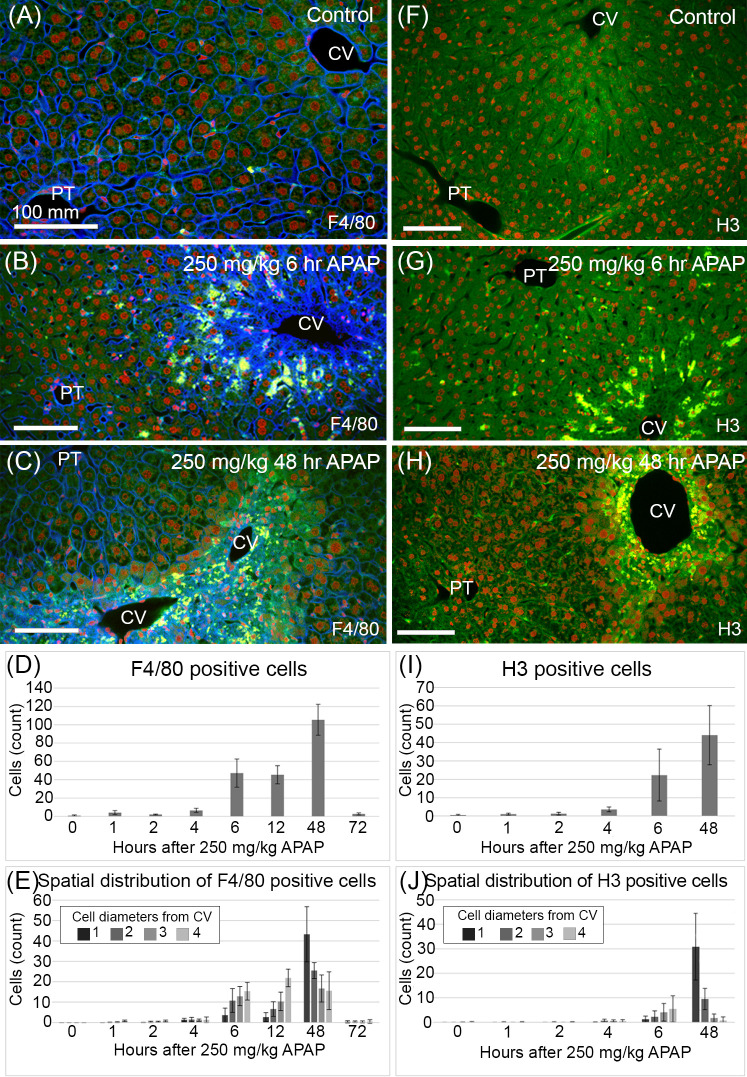
Levels and localization of resident and infiltrating Kupffer cells and cell proliferation after APAP induced centrilobular necrosis.(A-C) F4/80 labeling (yellow) identifies resident and infiltrating Kupffer cells. (F-H) H3 labeling (yellow) identifies proliferating cells. (A-C, F-H) Sections were counterstained to visualize cells using Lens Culinaris Agglutinin (LCA, green), nuclei using Sytox Green (red) and additionally in (A-C) plasma membranes of endothelial cells and hepatocytes using Tomato Lectin (TL, blue). The TL label also allows visualization of the prominent intracellular membrane bound regions in hydropic hepatocytes. (D,E) and (I,J) F4/80 and H3 positive cell counts are expressed as mean ± s.d. per 100,000 μm2. (D) Macrophage counts greatly increase by 6 hours after APAP. Cell counts increase further by 48 hours after APAP. Kupffer cell counts return to normal by 72 hours after APAP. (E,J) Labeled cells (yellow) are counted within 1,2,3, and 4 cell diameters from central veins. (E) Kupffers are concentrated at the periphery of the necrotic region (4 cell diameters from the CV) at 6 and 12 hours after APAP. By 48 hours after APAP, the centrilobular damaged region has been almost filled with hepatocytes and macrophages are concentrated at the CV (within 1 cell diameter from the CV). (J) Dividing cells are concentrated at the periphery of the necrotic region at 6 hours after APAP. By 48 hours after APAP dividing cells are concentrated near the CV.